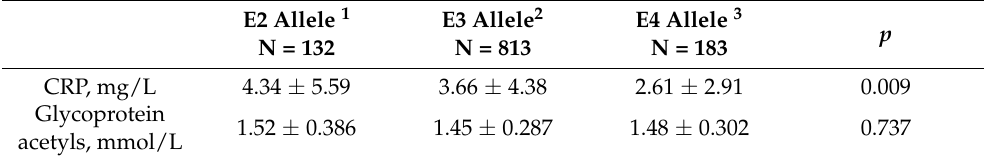
Table 5. CRP and GlycA levels according to APOE genotype in in a subsample from AWHS